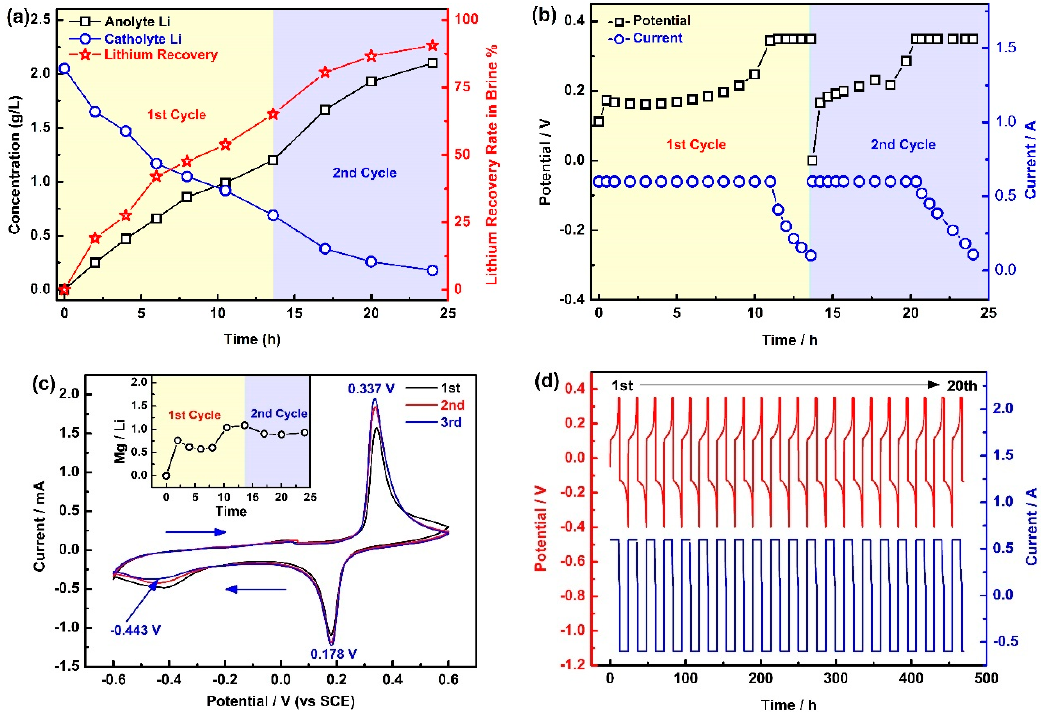
Figure 2. The EID system for lithium extraction. ( a ) Li + concentration and Li + recovery rate in the first two cycles; ( b ) current and voltage changes in two cycles; ( c ) the cyclic voltammetry (CV) curves of brine and the illustration shows the Mg / Li in the obtained anolyte; ( d ) charge and discharge cycle performance of the brine. SCE, saturated calomel electrode.